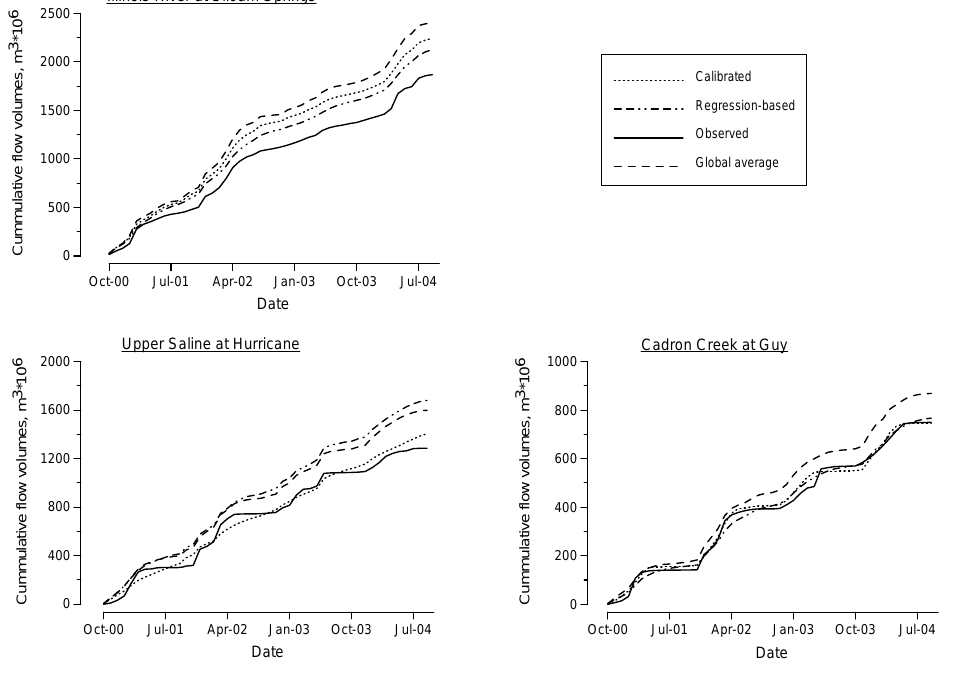
Figure 5. Inter-comparison of stream flow hydrographs as obtained using the various regionalization methods, and calibration for the period October 2000–September 2004.